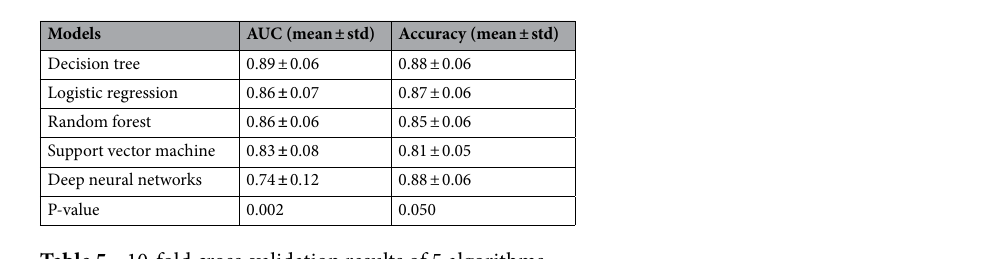
Table 5. 10-fold cross-validation results of 5 algorithms.